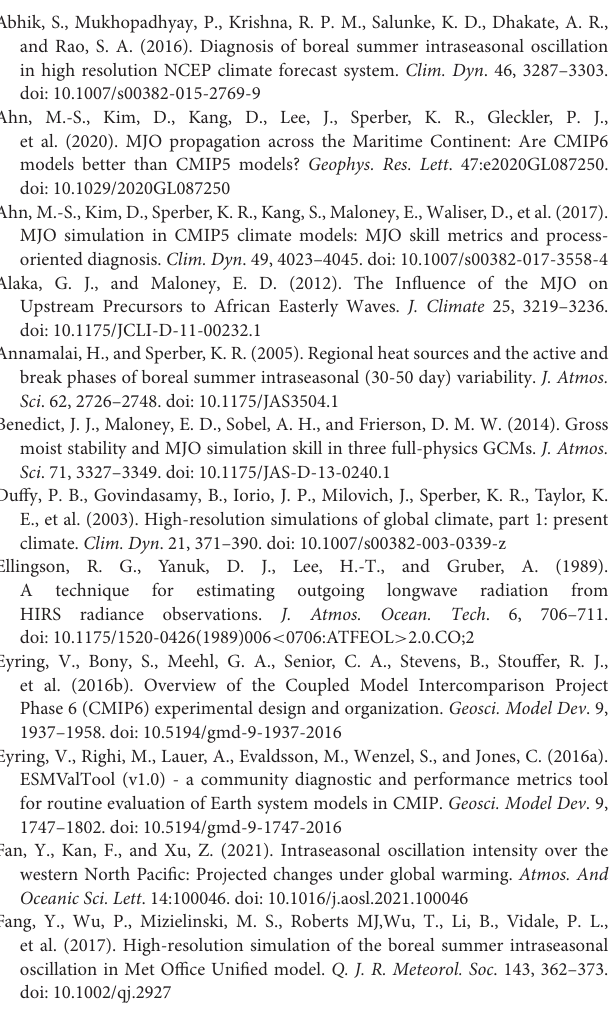
Supplementary Figure 6 | Eastward propagation of observed and simulation BSISO convection signal indicated by column integrated DSE (shaded) and 30–60-day rainfall anomalies (contours; starting from ± 0.2 to ± 0.6 at an interval of 0.2) averaged over 10 ◦ S − 10 ◦ N by lag-correlation against 30–60-day rainfall anomalies averaged over the equatorial Indian Ocean (5 ◦ S and 5 ◦ N, 80 ◦ E and 100 ◦ E). Supplementary Figure 7 | The observed and simulated monthly mean rainfall during May–October 1997–2014. The pattern correlation (r) and the root mean squared error (rmse) values between the simulated patterns and that of GPCP are indicated. Supplementary Figure 8 | The observed and simulated monthly mean specific humidity at 850 hPa during May–October 1997–2014. The pattern correlation (r) and the root mean squared error (rmse) values between the simulated patterns and that of ERA5 are